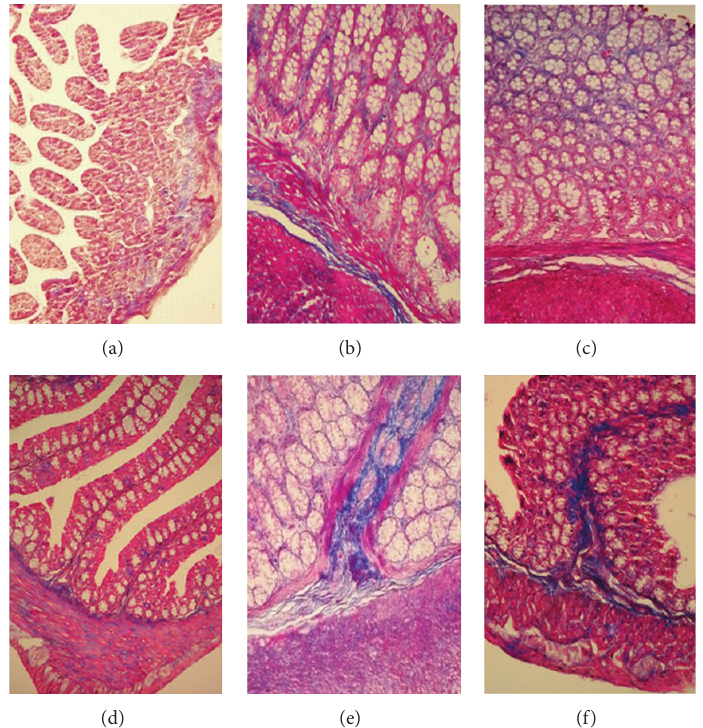
Figure 3: Masson’s trichrome stain ( × 400) indicates that collagen deposition (blue) is located mainly in the mesenchymal, mucosa layer, submucosal areas, and muscularis propria in IL-10KO mice at 12 (d), 14 (e), and 16 (f) wk. Little collagen deposition was found in the mesenchymal layer in WT mice (a). IL-10KO treated with IL-10 5 𝜇 g/kg body weight, three times per week at 14 (b) and 16 (c), have less collagen in the submucosal areas and muscularis